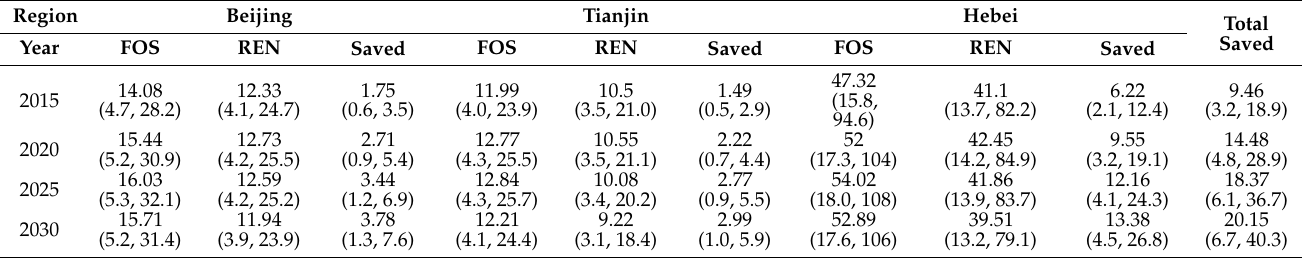
Table 7. The monetary value of premature deaths (Billion CNY in 2002 price) 1